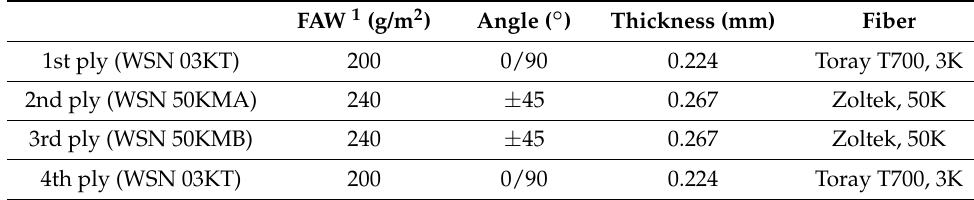
Table 1. Carbon fabric prepreg